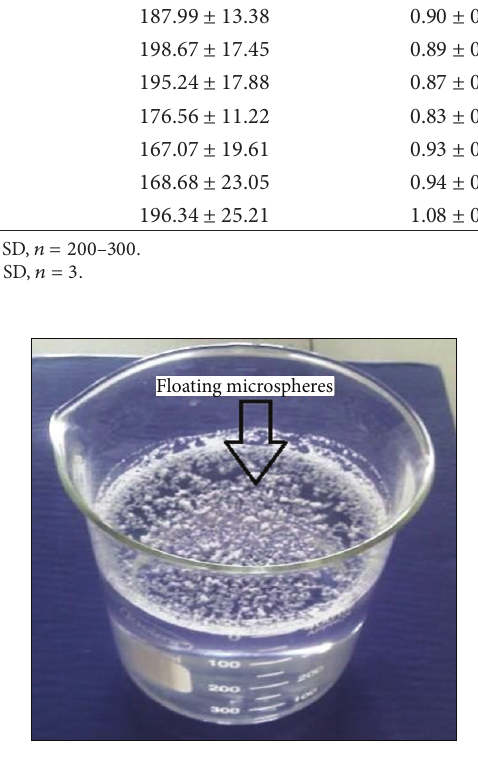
Figure 3: Floating hollow